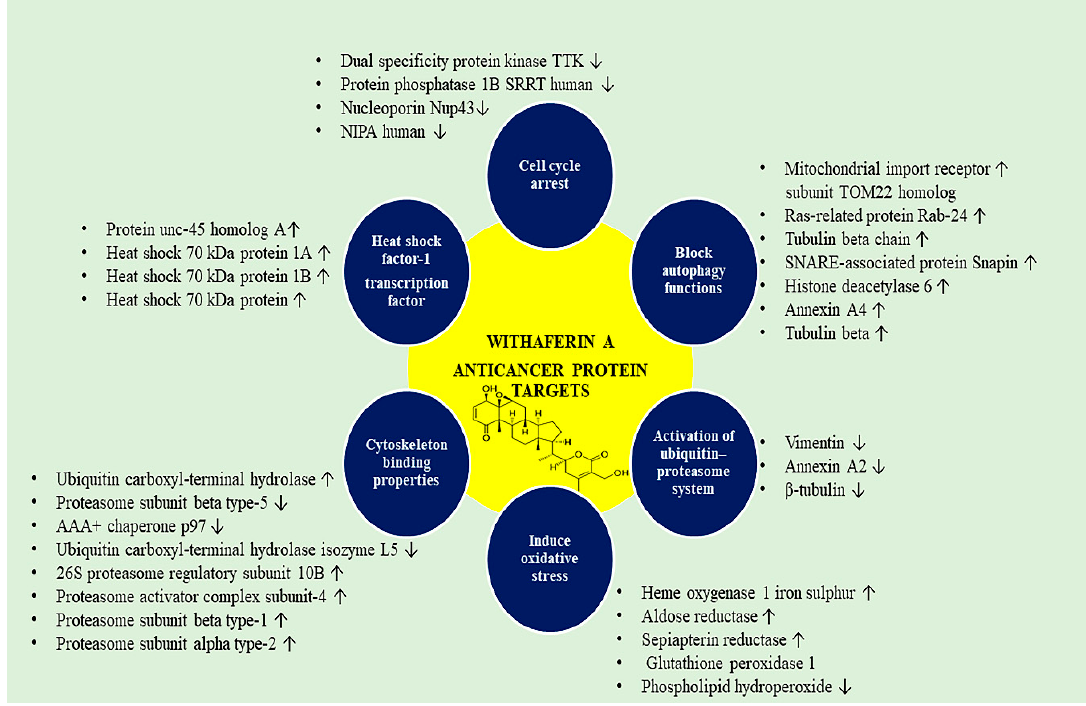
Figure 3. Withaferin A associated anticancer protein targets .